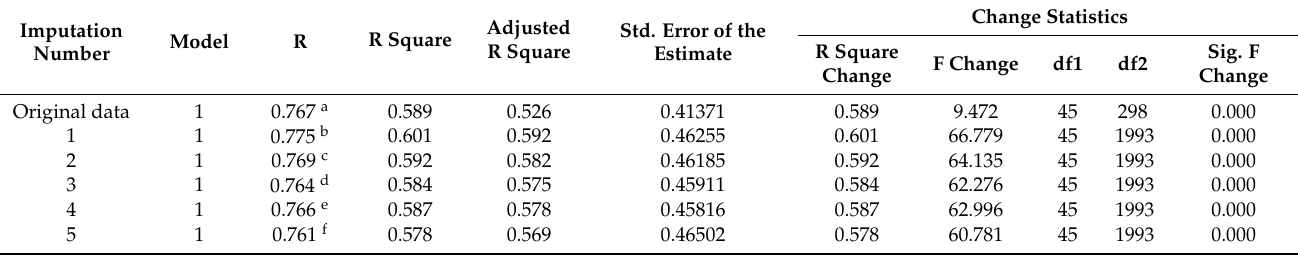
Table 3. Model summary for AOD use susceptibility across original and imputed data